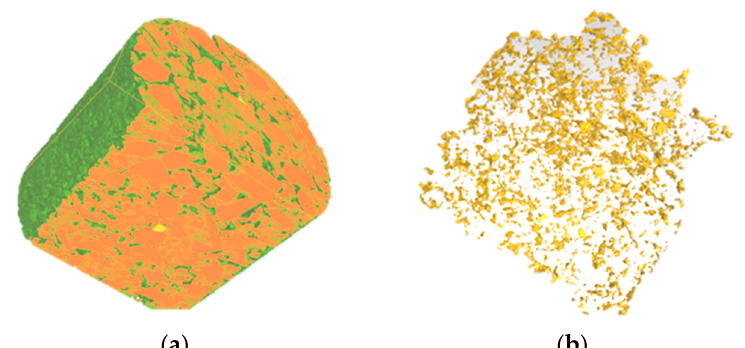
Figure 3. Digital sample and void of asphalt mixture. ( a ) Three-dimensional digital sample; ( b ) three-dimensional distribution of void.